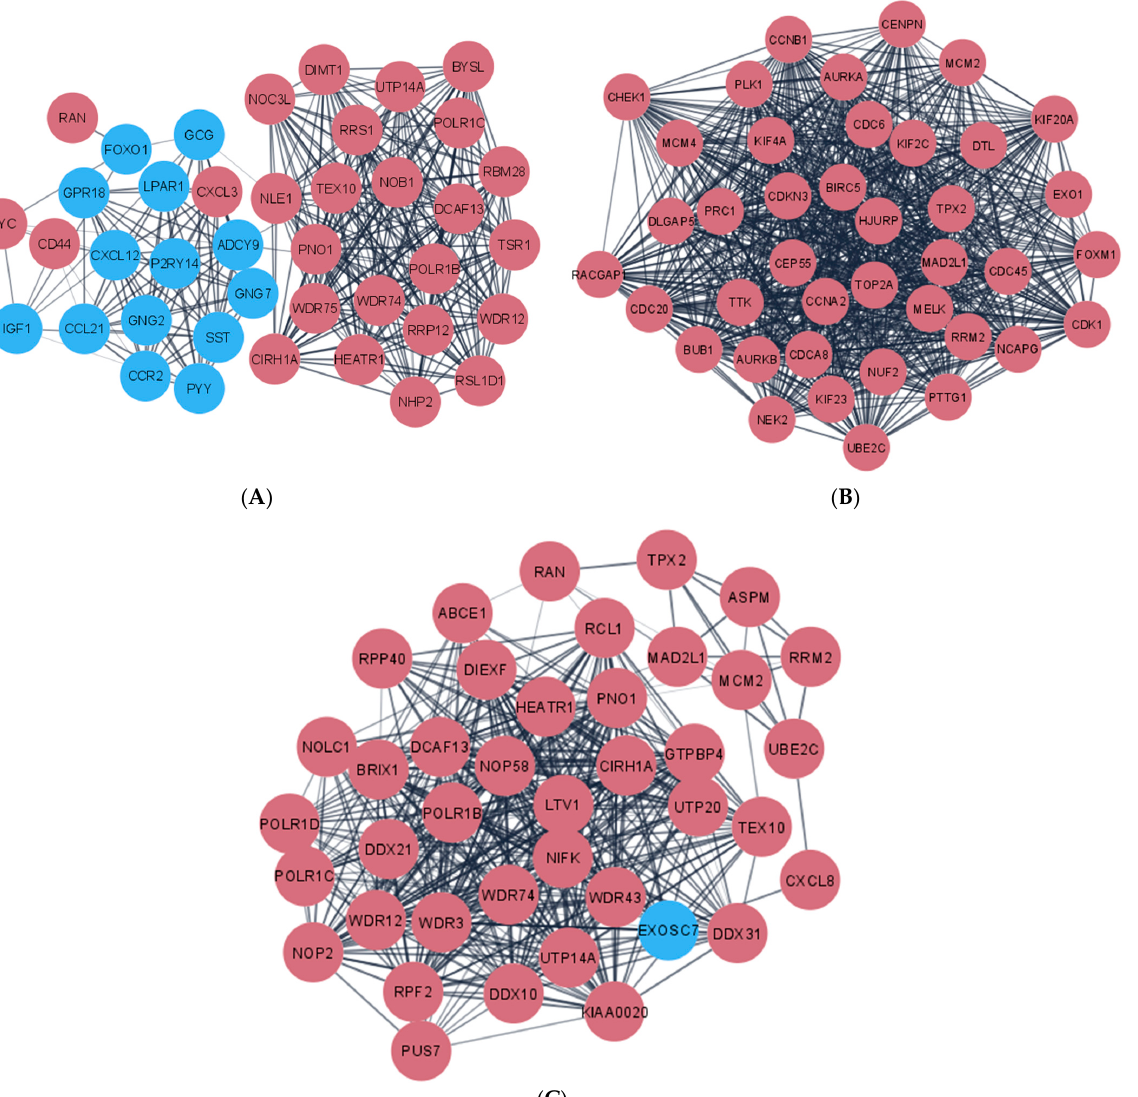
Figure 5. ( A ) Top 40 hub genes in G1. ( B ) Hub genes in G2. ( C ) Hub genes in G3. Dark red color—UR; Blue color—DR.